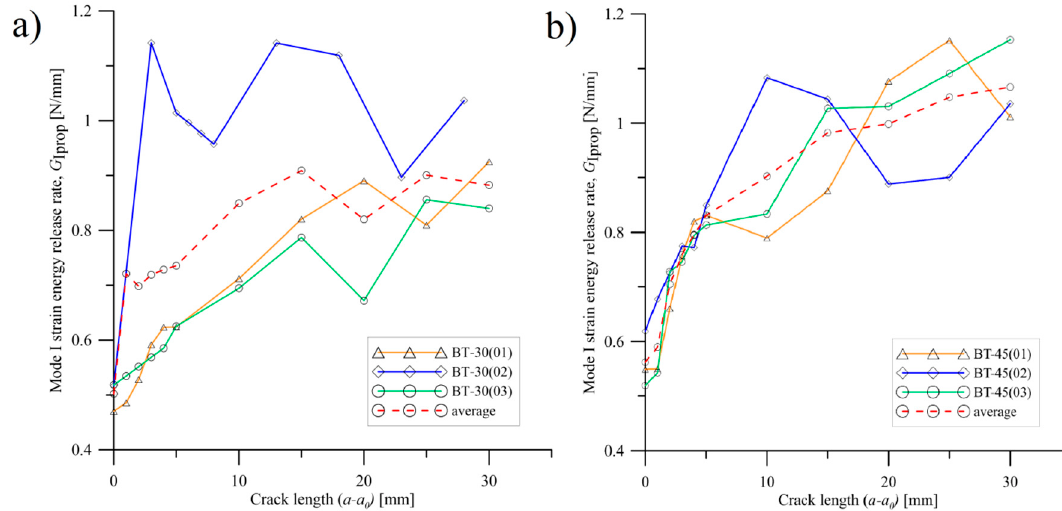
Figure 10. R -curves obtained for ( a ) the BT30 and ( b ) the BT45 laminates.